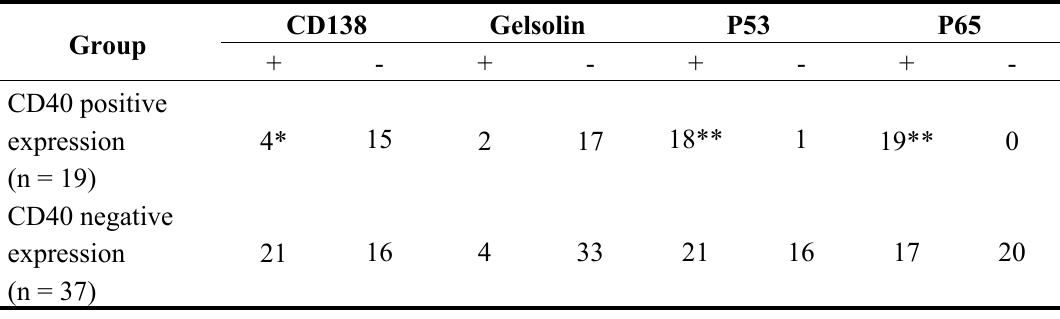
Table 4. Correlation of CD40 with relative molecules in gastric cancer tissues.